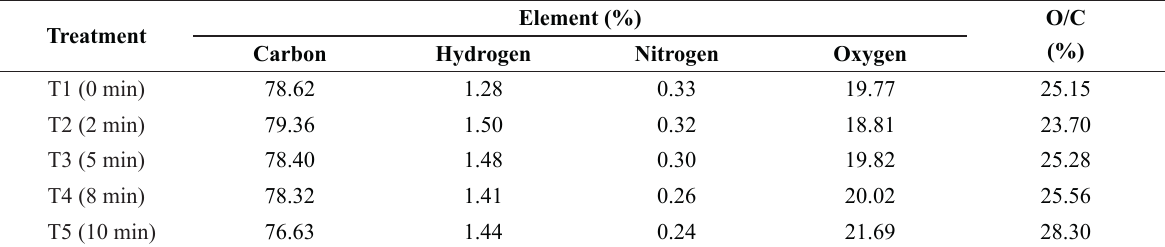
Elemental analysis of each treatment.